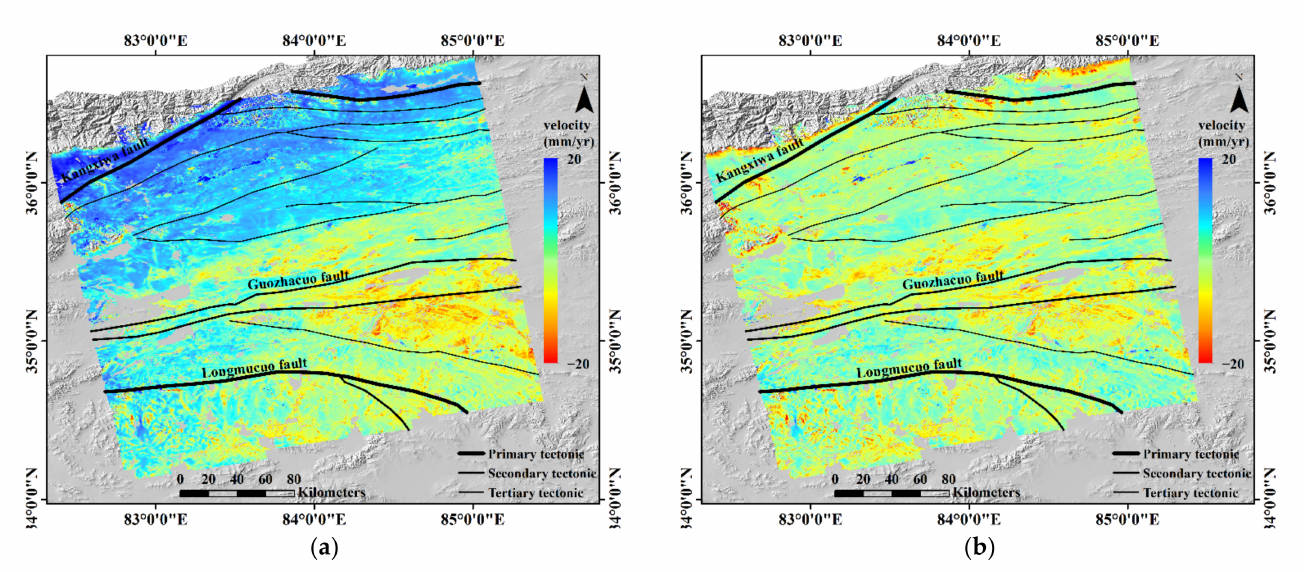
Figure 3. ( a ) Deformation rate before spatiotemporal filtering. ( b ) Deformation rate after spatiotem- poral